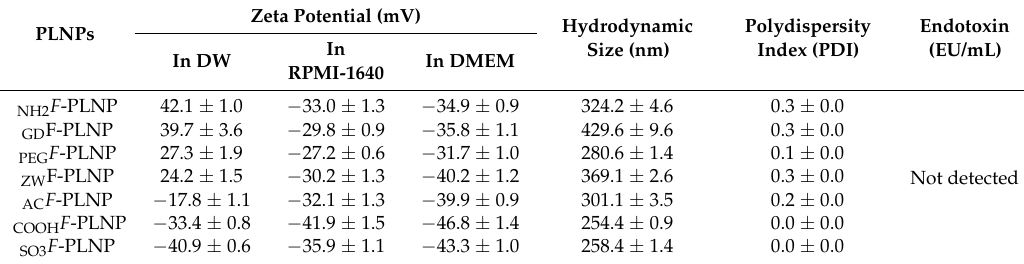
Figure 2. Morphology and fluorescence intensity of nanoparticles. The representative ( a ) TEM and ( b ) SEM image of amine ( NH2 ) F -PLNPs. Fluorescence intensity ( c – i ) of nanoparticles was analyzed using flow cytometry: ( c ) ( NH2 ) F -PLNP, ( d ) guanidium ( GD ) F -PLNP, ( e ) polyethylene glycol ( PEG ) F -PLNP, ( f ) acetyl ( AC ) F -PLNP, ( g ) zwitterionic ( ZW ) F -PLNP, ( h ) carboxyl ( COOH ) F -PLNP, and ( i ) sulfonic ( SO3 ) F -PLNP. Table 1. Physicochemical properties of the